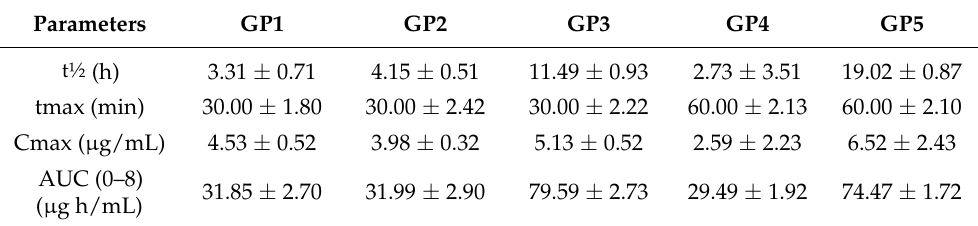
Table 7. Pharmacokinetic study of in vitro release profiles of ACZ and CAR loaded niosomes formulations through membrane compare to their solution.